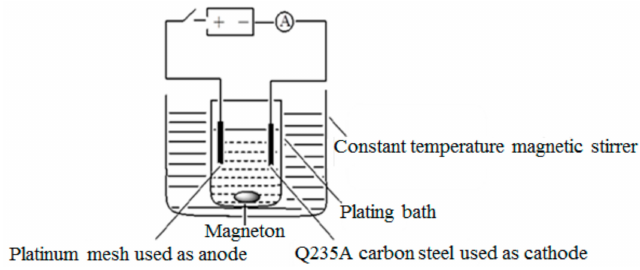
Figure 3. Schematic diagram of the electroplating device.